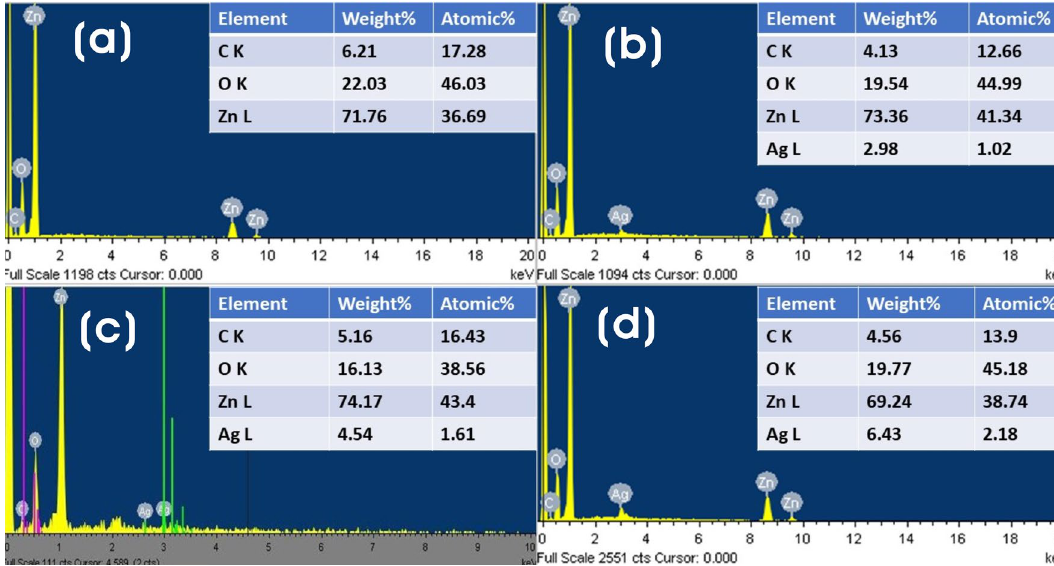
Figure 5. FE-SEM–EDX spectra of ( a ) ZnO, ( b ) Ag 0.2 @ZnO, ( c ) Ag 0.4 @ZnO, and ( d ) Ag 0.8 @ZnO NCs (inset table with elemental